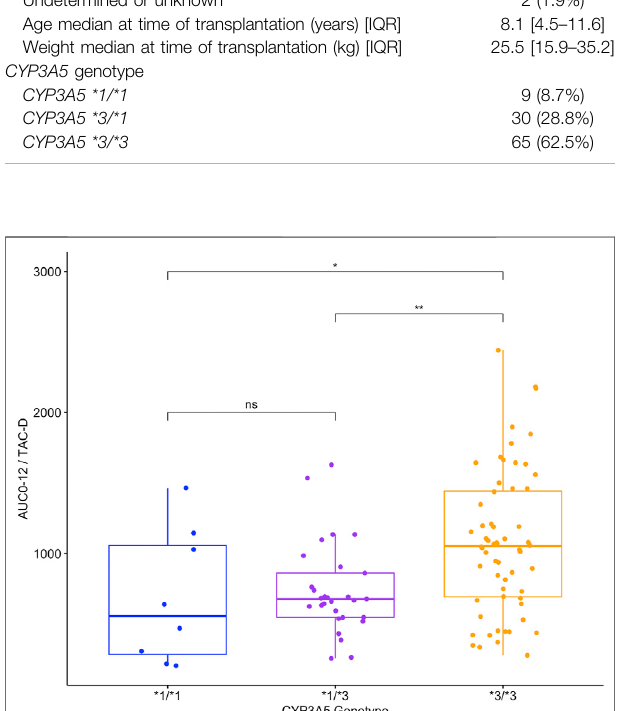
FIGURE 1 | Area under the curve in 12 h normalized by TAC dose requirements (AUC 0-12h /TAC-D ng*hr/ml/mg/kg) in 97 patients with different CYP3A5 genotypes.